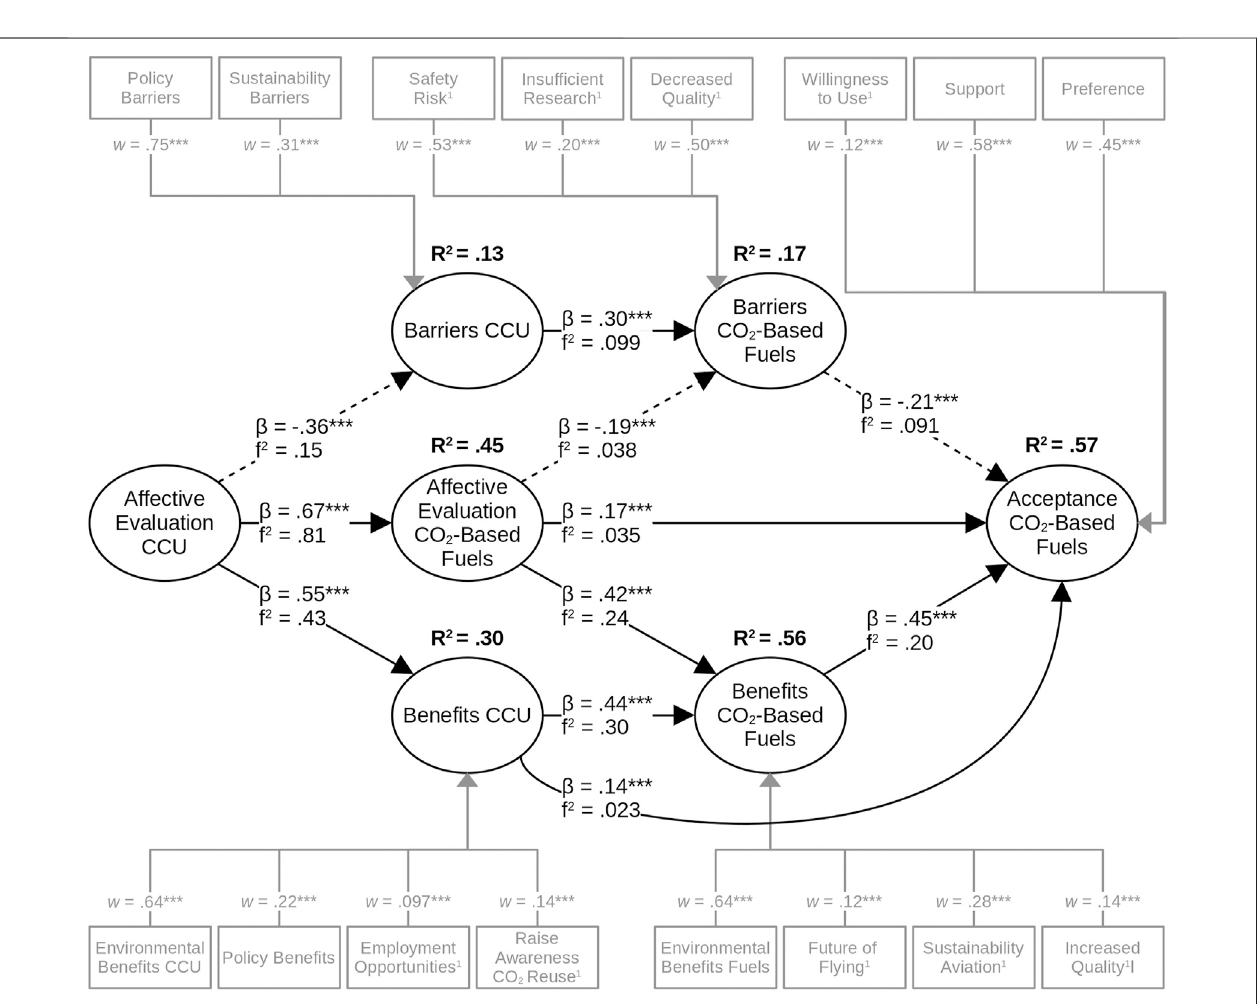
FIGURE3| Finalstructuralequationmodelwithsubcomponentsofhigher-ordercomponents.Thegraphicincludesoriginalestimateweights w ,pathcoef fi cients β (all ppp p < 0.001), effect sizes f 2 , and explained variances R 2 . Dashed paths indicate a negative path coef fi cient. 1 signi fi es a single-indicator composite.